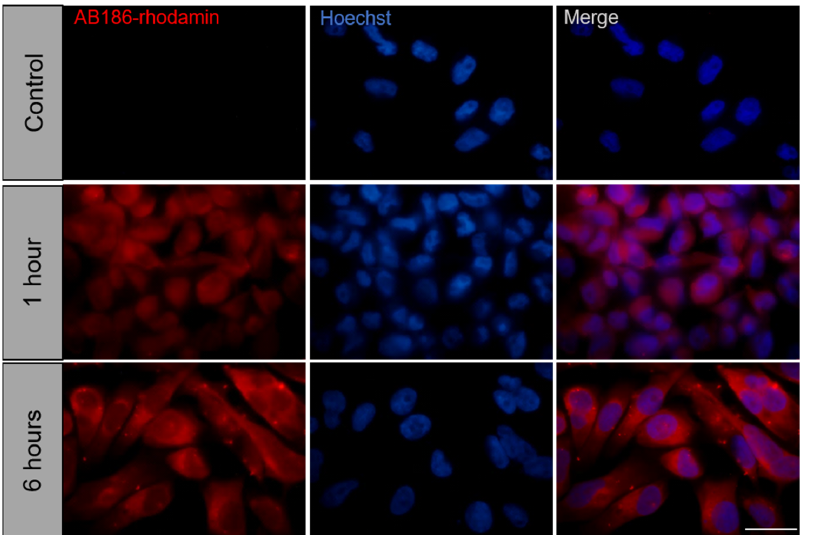
Figure 7. Rhodamin-labelled AB186 localizes in the cytoplasm of MDA-MB-231 cells. MDA-MB-231 cells were exposed to 3 µM of Rhodamin-labelled AB186 during 1 or 6 h. Control cells were exposed to the unlabeled compound. Cells were fixed with paraformaldehyde and cell nuclei were labelled with Hoechst dye. Bar represents 50 µm.